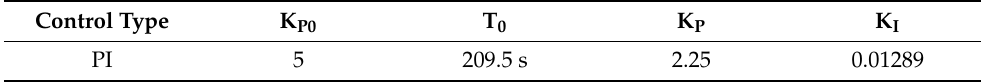
Table 2. PI control